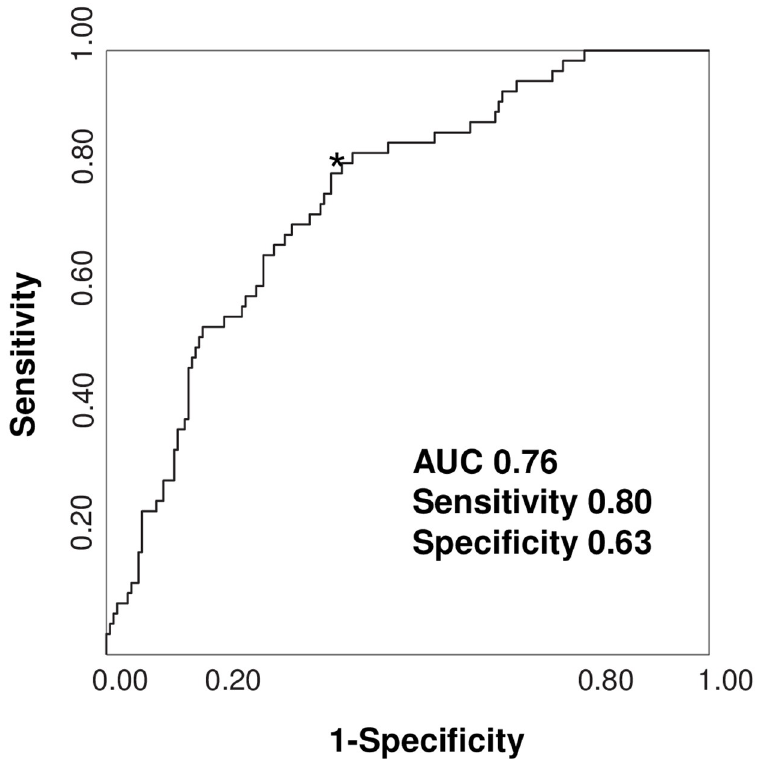
Fig 1. Determination of the cut-off value of baseline serum total bilirubin levels for predicting Progressive Renal Decline (PRD) by ROC curve. The area under the curve (AUC) of receiver operating characteristic (ROC) analysis for progressive renal decline was 0.76, with sensitivity 0.80 and specificity 0.63, and the cut-off value of baseline serum total bilirubin levels were 0.5 mg/dL.